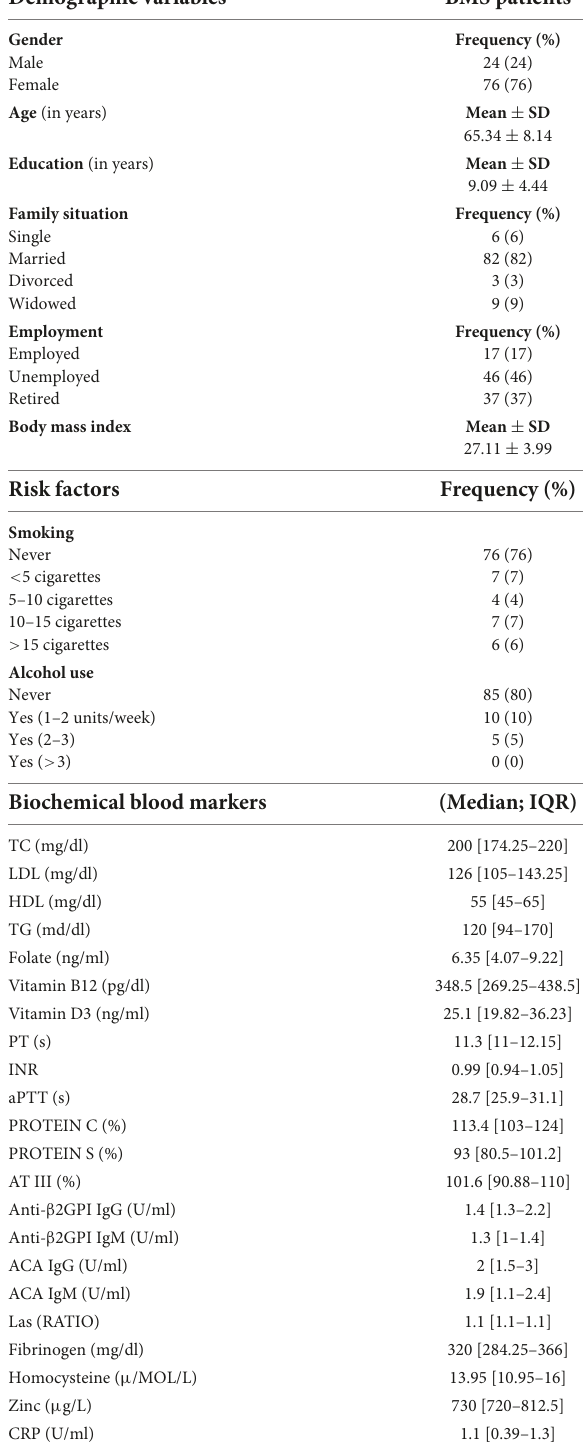
TABLE 1 Sociodemographic profile, risk factors and analysis of biochemical blood markers in 100 BMS